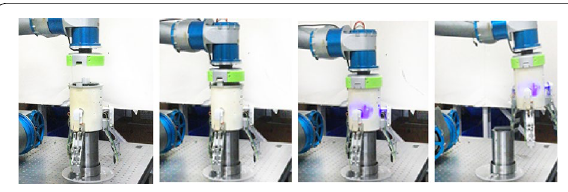
Figure 21 Connection process of the electromagnetic RCM